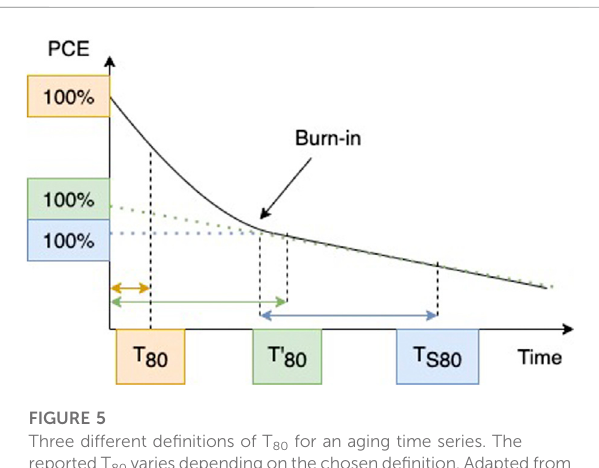
FIGURE 5 Three different de fi nitions of T 80 for an aging time series.